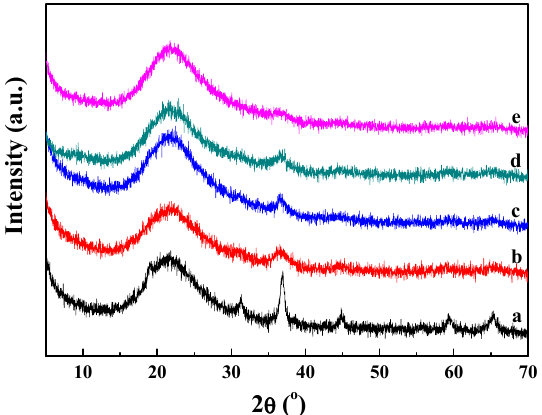
Figure 3. XRD patterns of the calcined catalysts for Co / SiO 2 (a), Co-3gly / SiO 2 (b), Co(1gly) / SiO 2 (c), Co(3gly) / SiO 2 (d), and Co(5gly) / SiO 2 (e).